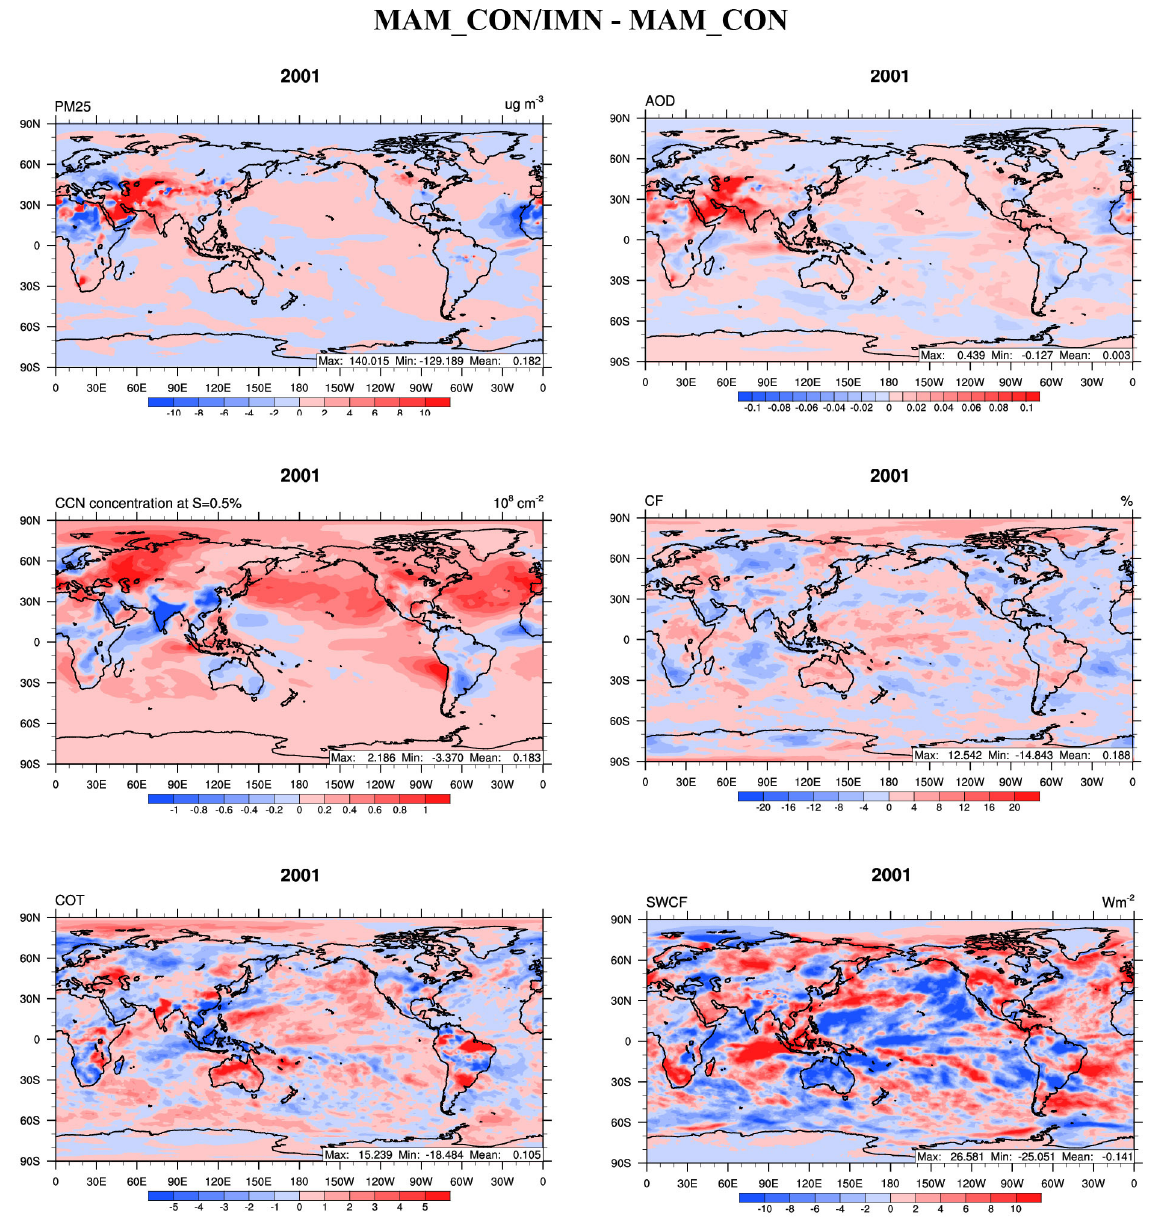
Figure 5. Absolute differences of PM 2 . 5 , AOD, column CCN5, CF, COT, and SWCF between MAM_CON/IMN and MAM_CON for